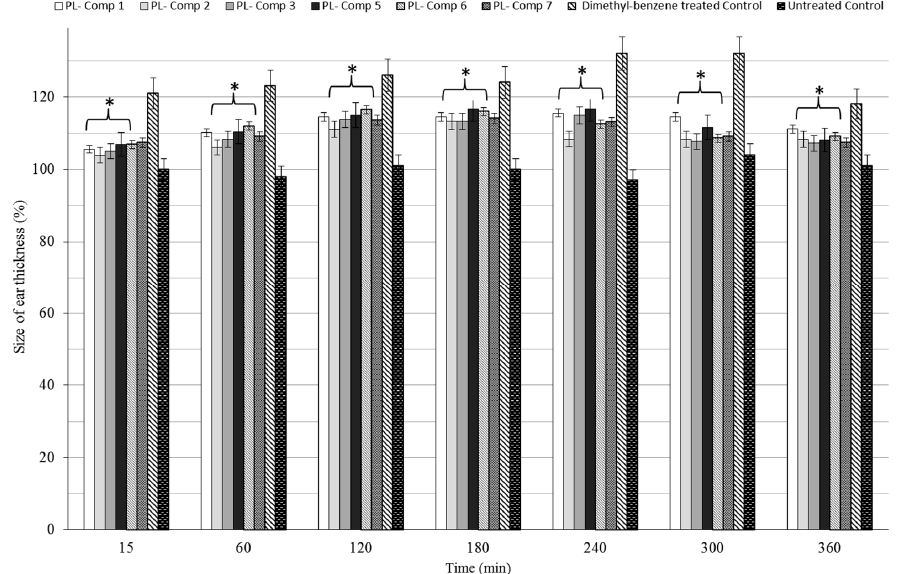
Figure 6. Time revolution of baseline corrected ear thickness (µm) in terms of different SNEDDS compositions containing 10 mg/mL P. lanceolata extract in a dimethyl-benzene-induced ear edema model in mice. The administered extract dose was 150 mg/kg/day formulated in SNEDDS and administered by gavage. For the complete time period, compositions showed significant differences to the positive control. As positive control, mice were treated with dimethyl-benzene without PL-SNEDDS pre-treatment, while in the negative control group, the mice received no treatment. Values are expressed as means ± SD, n = 6. All groups receiving a treatment with PL-components 1 – 3 , 5 – 7 differed significantly from their positive control group. Asterisk shown these significant differences.